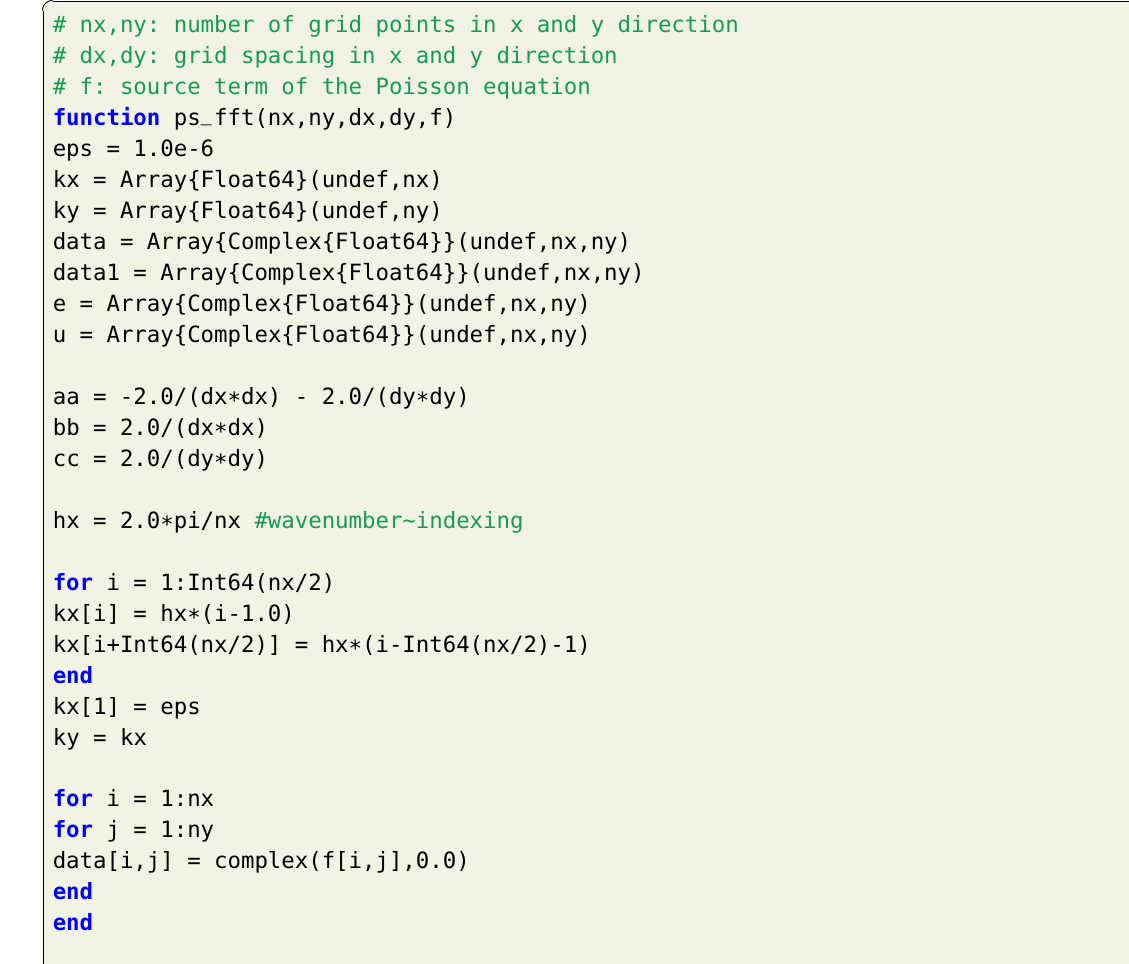
Listing 18. Implementation of Julia function for the Poisson solver using fast Fourier transform (FFT) for the domain with periodic boundary condition.